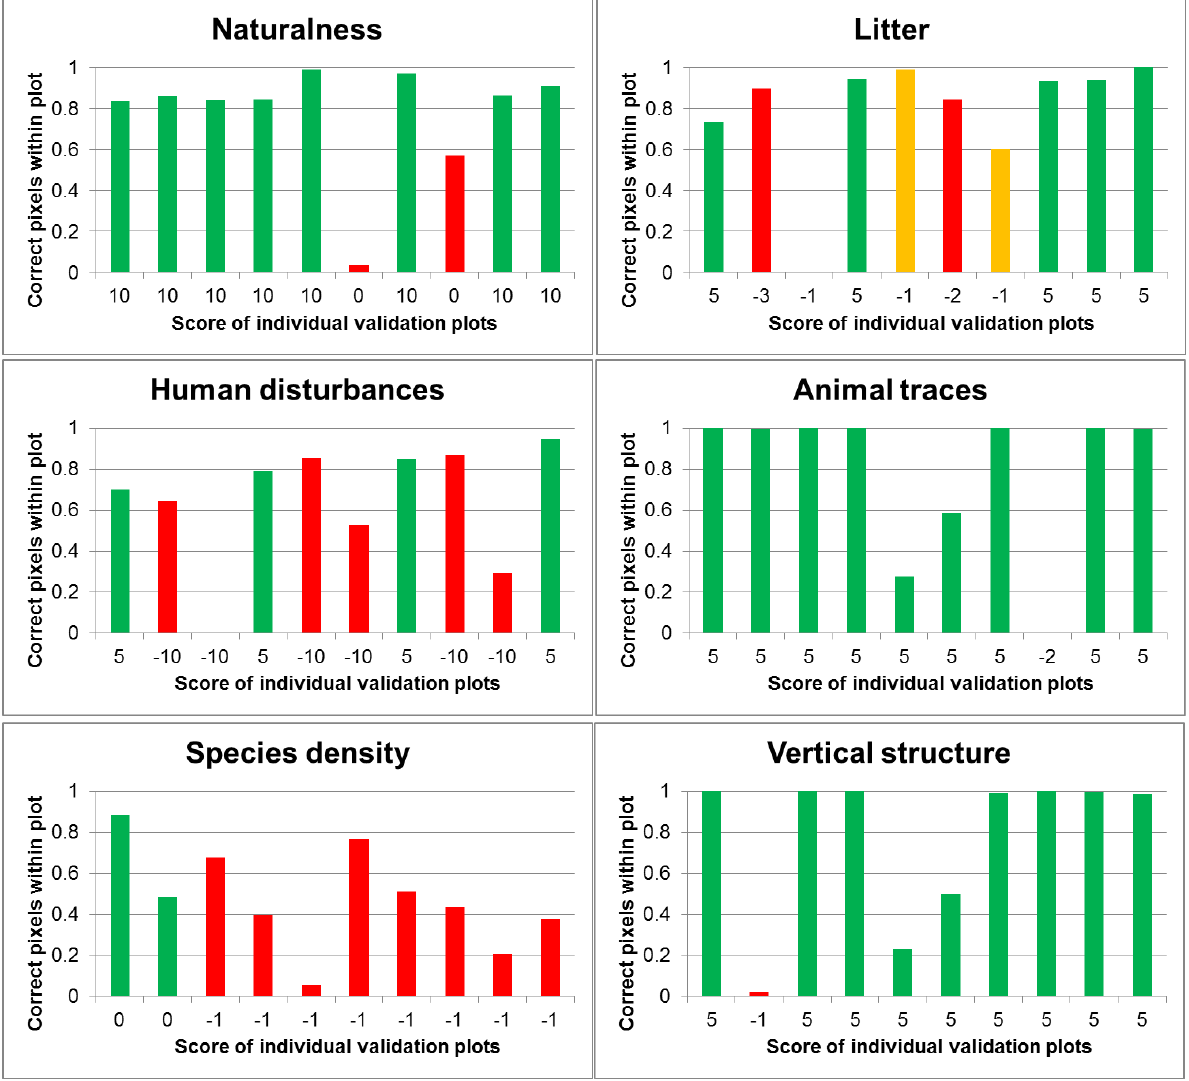
Figure 3: Ratio of correctly categorized validation plot pixels based on LIDAR data for individual conservation status parameters. Red and orange columns represent unfavourable status for the respective indicator, green columns stand for favourable